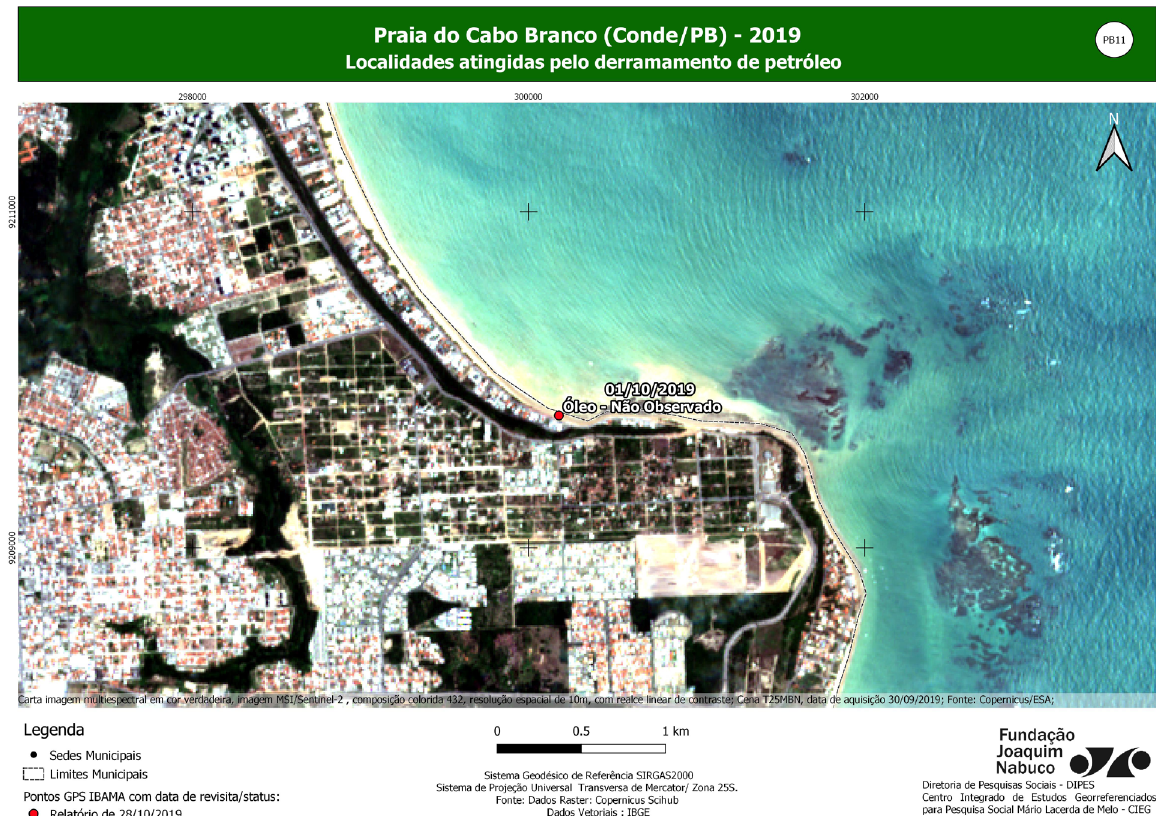
Figure 7. Multispectral image map of the beach affected by the disaSter. Source: Authors’ elaboration from the digital image processing of the sensor / satellite MSI /